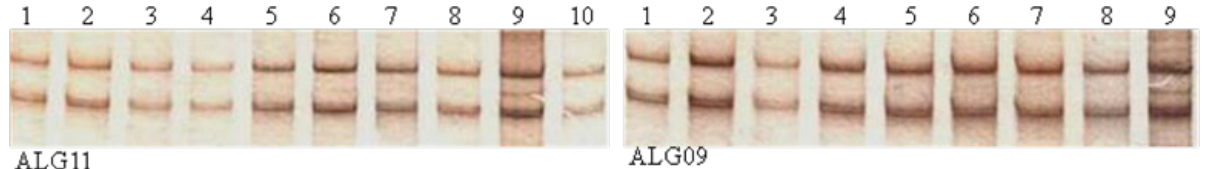
Figure 1. SSCP patterns obtained from the cloned CP gene of isolates ALG11 and ALG09.